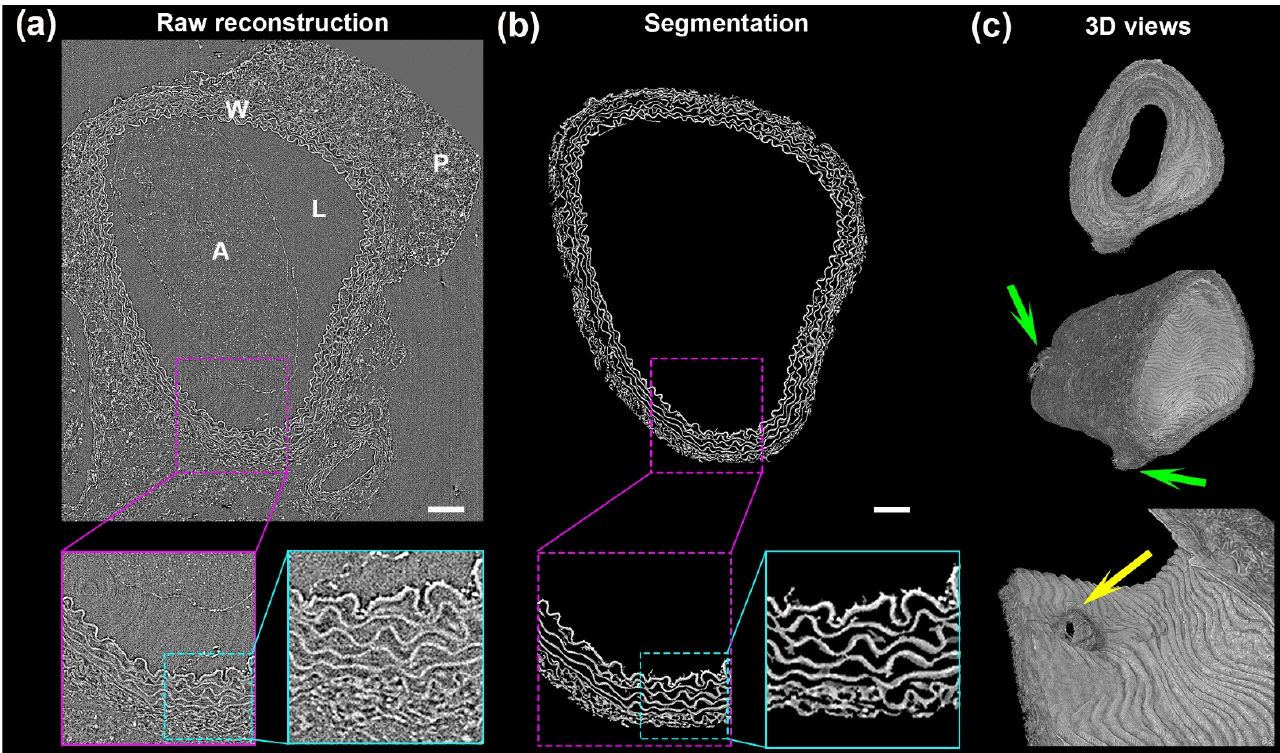
Figure 1. Typical result of a synchrotron X-ray microtomography acquisition with in-line phase- contrast of a paraffin-embedded 6-month C57Bl6J (control) thoracic aortic segment. The voxel size is 0.65 µm and all images are from the same acquisition. ( a ) One 2D raw reconstruction plane shows the lumen (L) of the artery surrounded by the arterial wall (W) itself surrounded by the perivascular adipose tissue (P). Some agarose (A) remains in the lumen after sample preparation. Successive magnification steps (purple and cyan) reveal details of the plane. ( b ) Results of the same areas after segmentation of the elastic structures and magnifications (purple and cyan) demonstrate the preci- sion of the automated segmentation. ( c ) 3D views of a full volume reconstruction (2048 × 2048 × 2048 voxels). Front view ( top ) clearly shows the luminal face, three-quarters view ( middle ) shows 1.33 mm of the reconstruction with two secondary artery branching (green arrows). Inside view ( bottom ) of a secondary artery connection (yellow arrow). Scale bars = 100 µm.